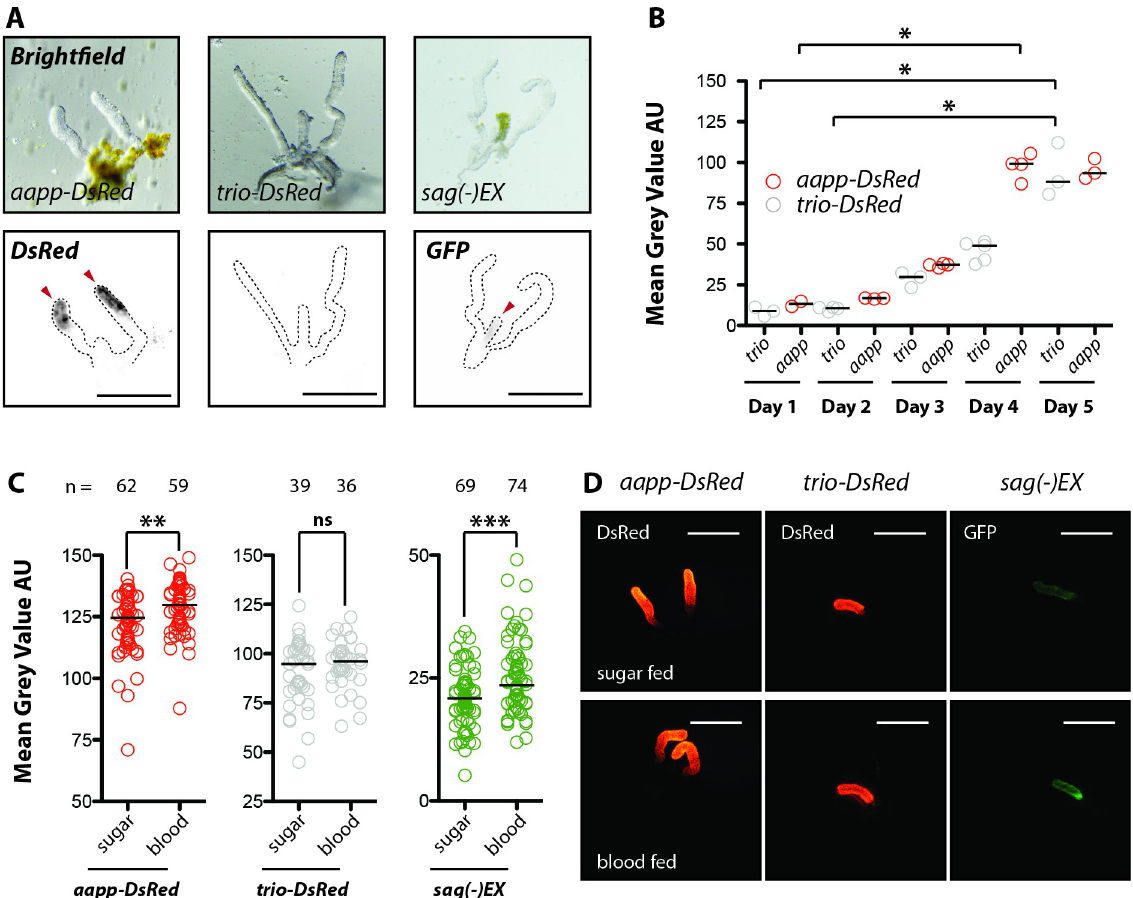
Fig 2. Onset, strength and inducibility by blood feeding of reporter expression in aapp-DsRed , trio-DsRed and sag(-)EX mosquitoes. A) Images of salivary glands dissected directly after mosquitoes emerged. Fluorescence signals were observed in salivary glands expressing aapp- DsRed and sag(-)EX (marked by red arrowheads) but not trio-DsRed . Scale bar: 250 μ m. B) Mean fluorescence intensity measurements of dissected aapp-DsRed and trio-DsRed salivary glands from day one to day five after hatching. Data were normalized for the highest exposure time. Each dot represents a single gland (2–5 glands / timepoint) and bars the median. � p < 0.01, one-way-ANOVA (Dunn’s Multiple Comparison Test). C) The blood meal inducibility of the trio , aapp and saglin promoters was assessed by providing sibling females either with a blood meal or sugar solution. Approximately 24h later, salivary glands were dissected, imaged and the mean DsRed or EGFP fluorescence intensities were quantified. Data pooled from three ( aapp-DsRed and trio-DsRed ) or four ( sag(-)EX ) independent experiments. Horizontal black bars represent the median. �� p < 0.001 and ��� p < 0.0001, Mann Whitney test. ns: not significant. D) Images of salivary glands dissected 24h after blood feeding in comparison to sugar fed controls. Scale bar: 250 μ m.